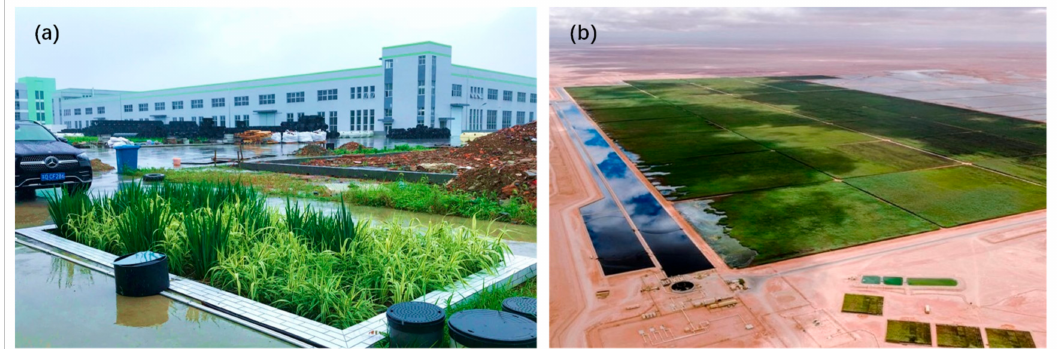
Figure 2. Small-scale constructed wetland in a water body near to a factory ( a ) and large-scale constructed wetland in the Middle East [36] ( b